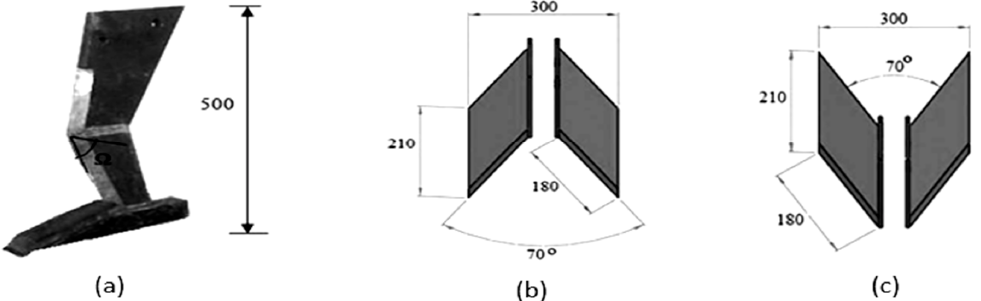
Figure 1. ( a ) Para-plow. Bend angle of para-plow leg or Ω was 45°; ( b ) Top view of the forward and ( c ) backward wings.